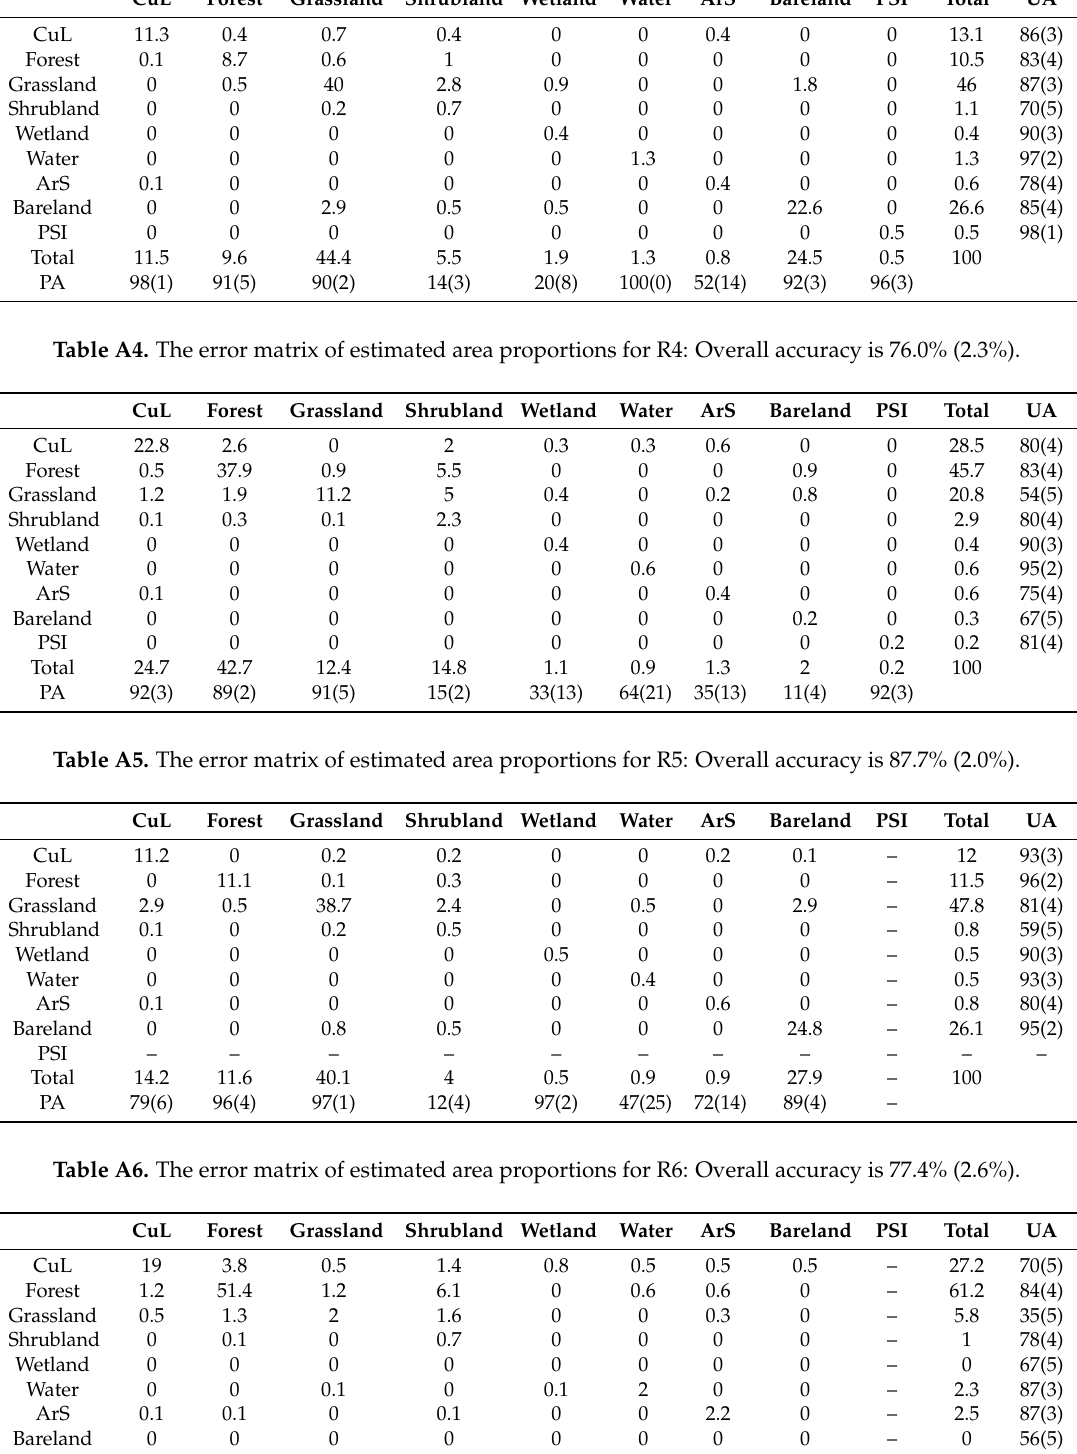
Table A3. The error matrix of estimated area proportions for R3: Overall accuracy is 85.9% (2.0%).